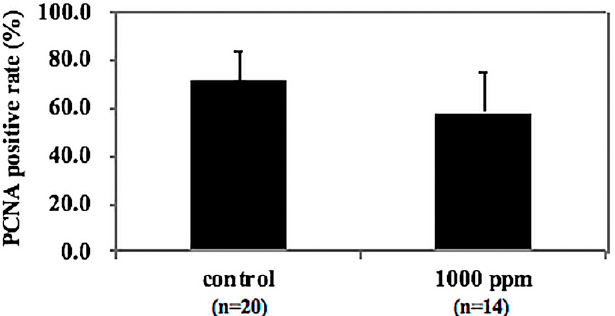
Figure 7. NZ-419 inhibited epithelial cell proliferation. Change in the ratio of proliferation cell nuclear antigen (PCNA)-positive cells in the intestinal polyps with NZ-419 treatment. Immunohistochemical staining for PCNA in the intestinal polyps of Min mice was performed in the basal diet group and 1000 ppm NZ-419-containing diet group. Calculations of the ratio of PCNA-positive cells are described in the Materials and Methods section. Bars indicate the SD ( n = 7~11).